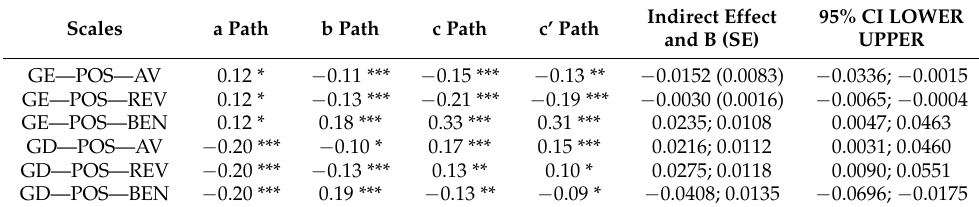
Table 3. Role of POS in God engaged/disengaged and interpersonal forgiveness (N = 464).